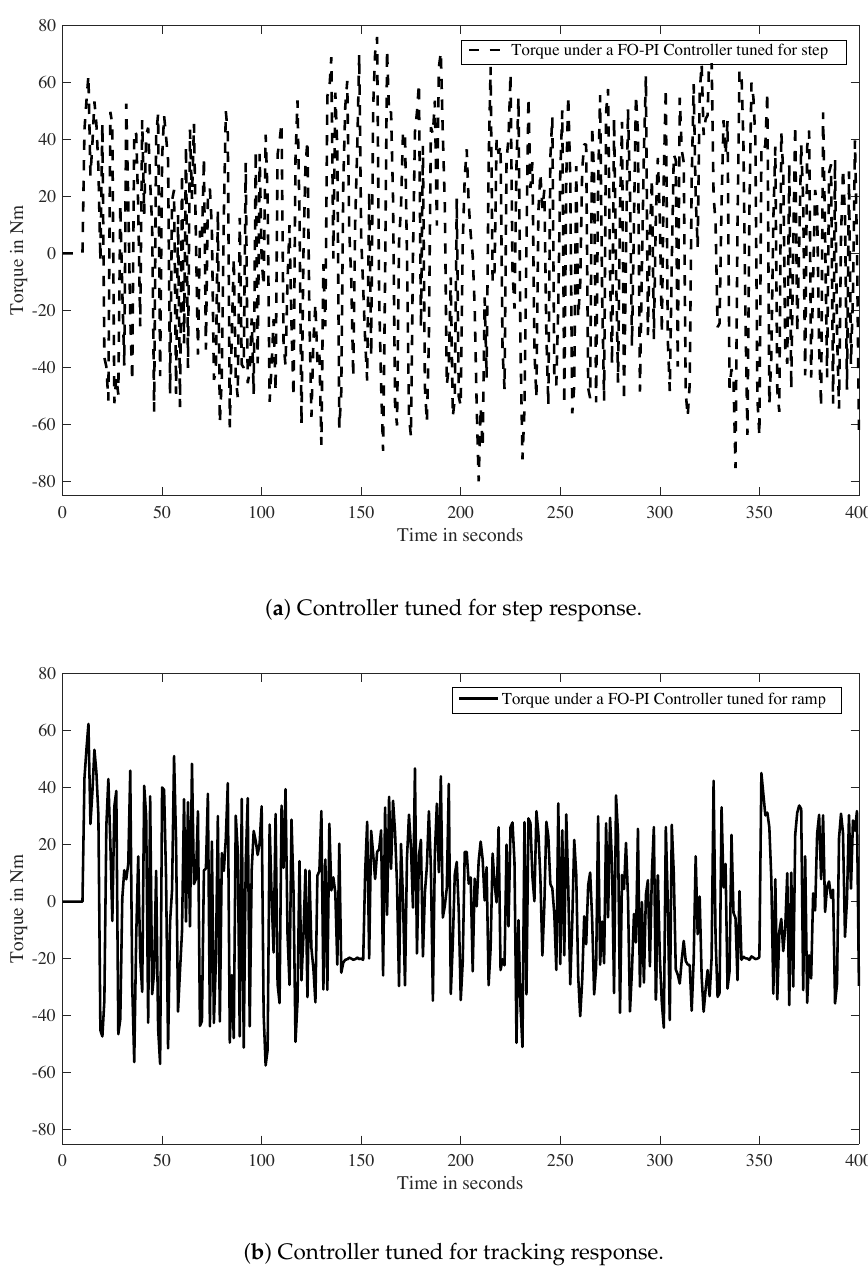
Figure 18. Motor torque with the system under a FO-PI